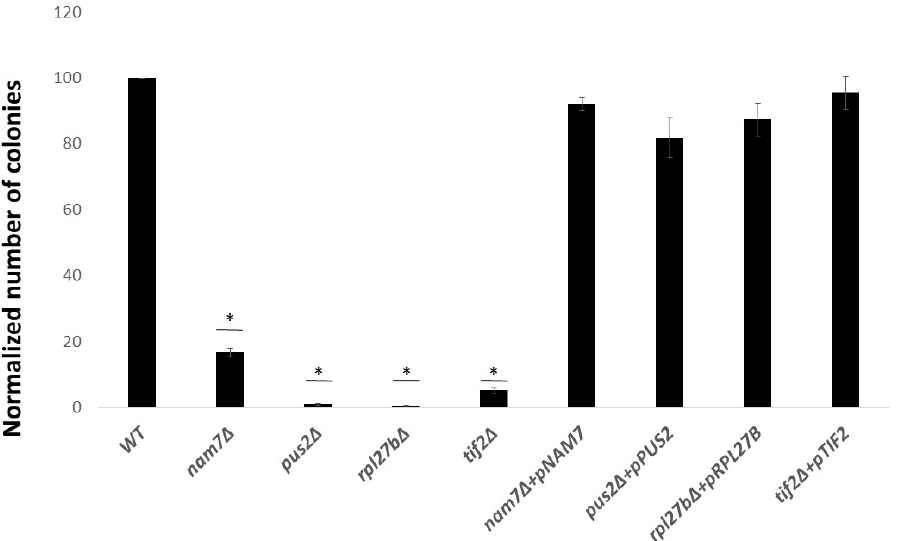
Figure 2. Quantitative analysis of LiCl sensitivity for di ff erent yeast strains. Average number of colonies formed for di ff erent yeast strains in the presence of LiCl (10 mM) were normalized to that for WT strain. nam7 ∆ , pus2 ∆ , and rpl27b ∆ show less colonies under LiCl treatment. Over-expression of target genes in their corresponding deletion mutants reverted cell sensitivity to LiCl. * ( p -value ≤ 0.05) represent statistically significant results compared to WT. Data represents the average from three independent experiments and error bars represent standard deviation.